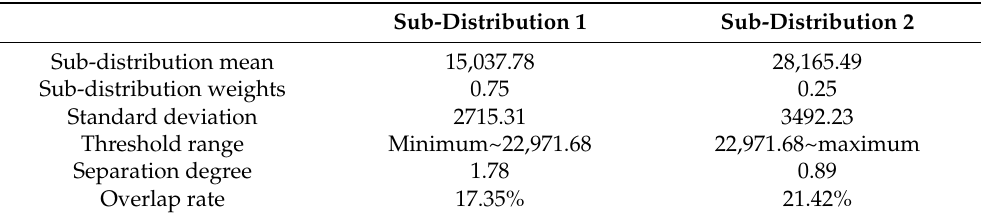
Table 3. Parameter values of each sub-distribution of the improved mixed monolithic sieving model for image